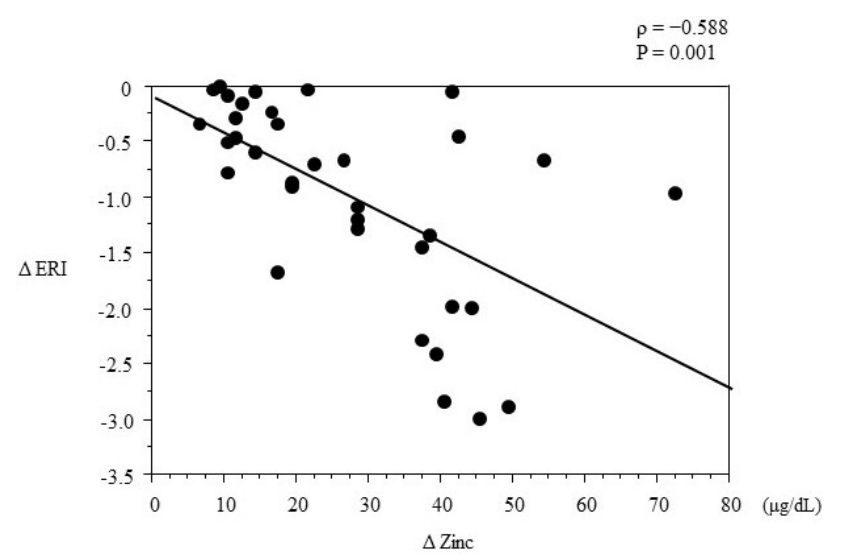
Figure 4. Correlation between ΔERI and Δzinc in the polaprezinc group. ΔERI was calculated as the difference between ERI at baseline and ERI at the end of the study (ERI at 12 months minus ERI at baseline), Δzinc was calculated as the difference between the serum zinc level at baseline and serum zinc level at the end of the